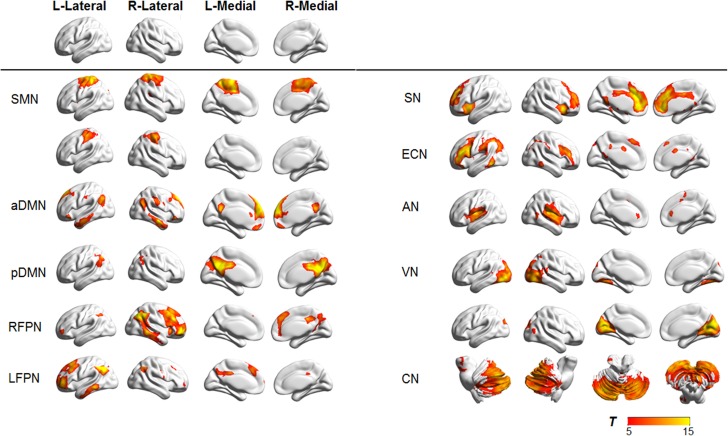
Cortical representation of brain networks identified in an independent component analysis.SMN: sensorimotor network; aDMN: anterior default-mode network; pDMN: posterior default-mode network; RFPN: Right frontoparietal network; LFPN: Left frontoparietal network; SN: Salience network; ECN: Executive control network; AN: Audio network; VN: Visual network; CN: Cerebellum network. L: left; R: right. Color bar represents the t values ranging from 5 to 15. Data are displayed on the lateral, medial surfaces of each hemisphere.